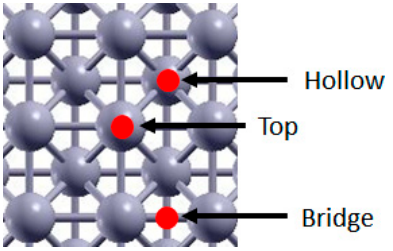
Figure 1. Rh (100) adsorption sites. Red spots indicate the site, Rh atoms are pictured in